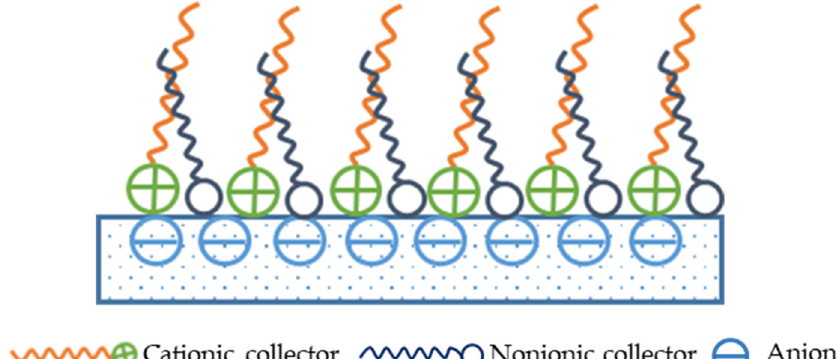
Figure 9. Coadsorption of cationic and nonionic surfactant at the quartz surface.